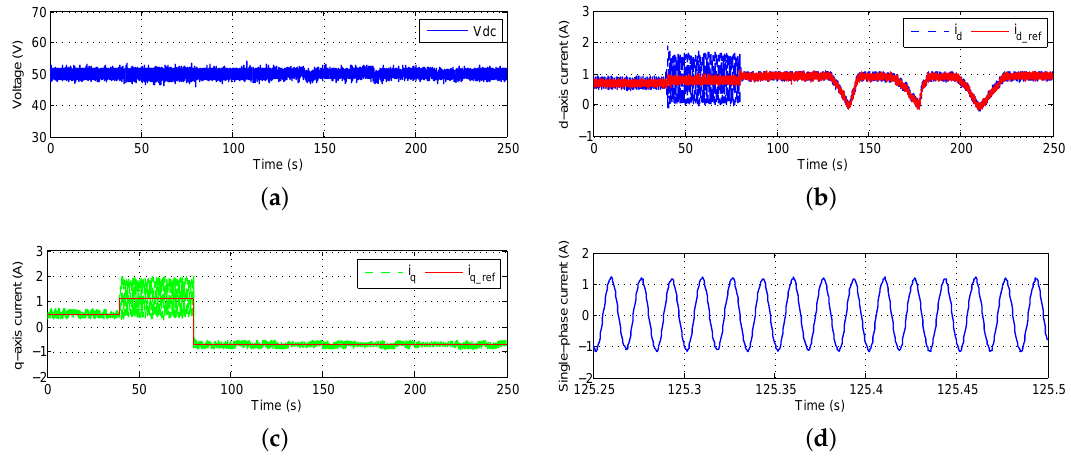
Figure 19. NN vector control for the AC/DC/DC converter with the LCL filter. ( a ) DC-link voltage; ( b ) PCC q -axis current waveform; ( c ) PCC q -axis current waveform; ( d ) single-phase current